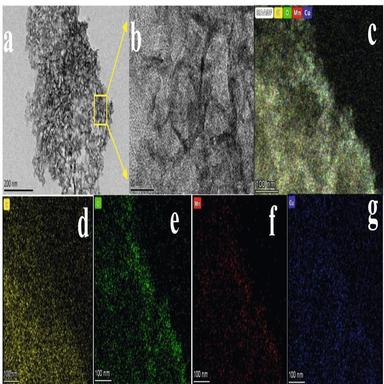
(a) and (b) TEM images at different magnifications, (c)–(g) element distribution maps of AC@MnCu-32.